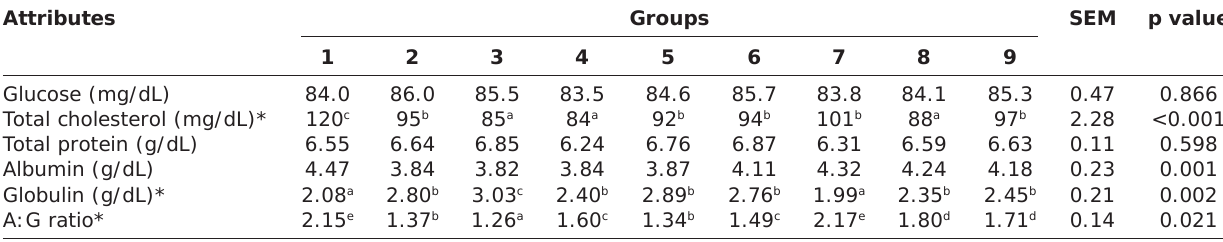
Table-2: Blood serum biochemical profile in different groups of male Wistar rats. Attributes Groups SEM p value